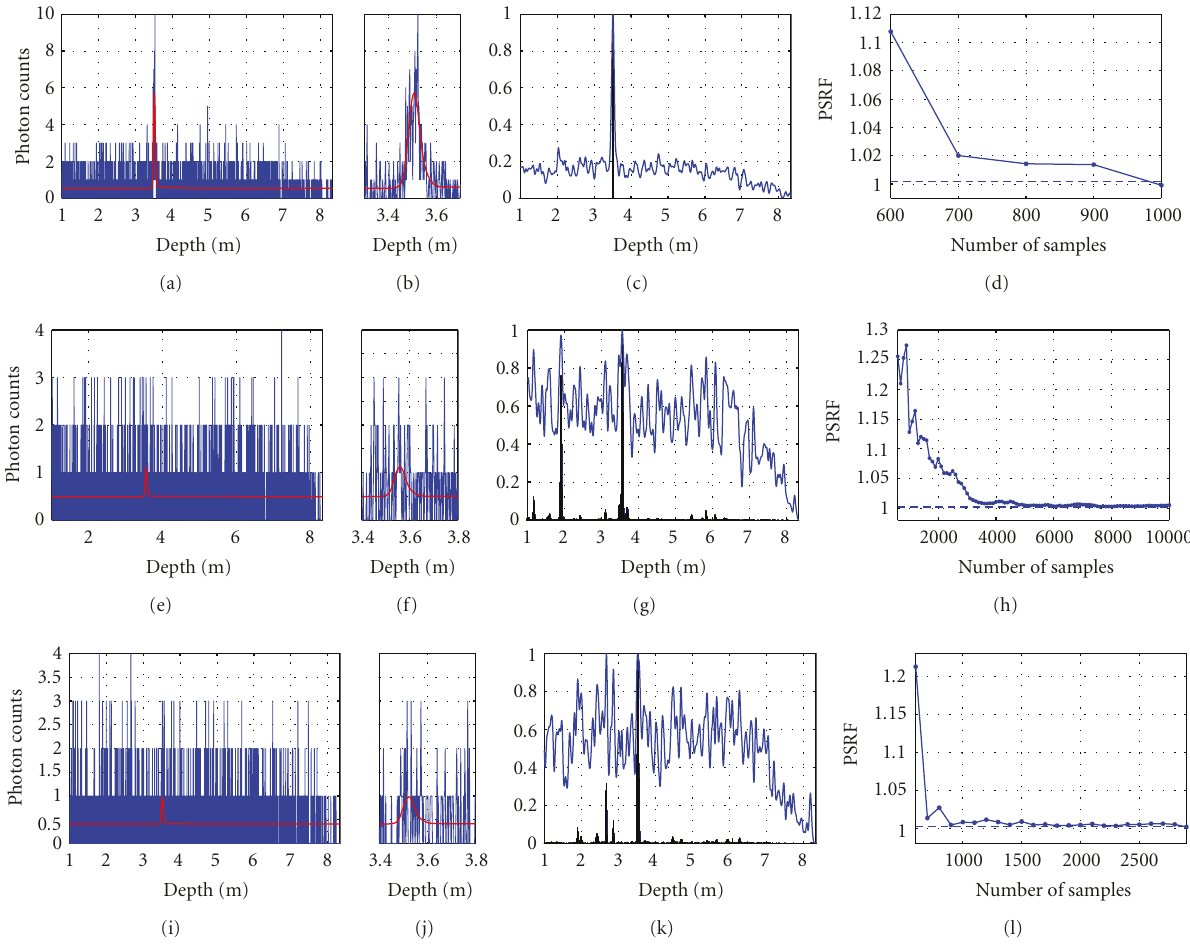
Figure 4: Analysis of time-of-flight ladar data, in which the histogram bins have been converted to relative depth in meters. The first column shows the raw pixel data (in blue). The second column magnifies the plots of signal peaks in the first column. The third column shows the normalized cross-correlation values (blue curves) and the frequencies of positions (black bars) obtained from the MCMC samplers. The last column tracks the corresponding PSRF values against the number of samples. The final fit estimations (from MCMC) are the red curves in the first